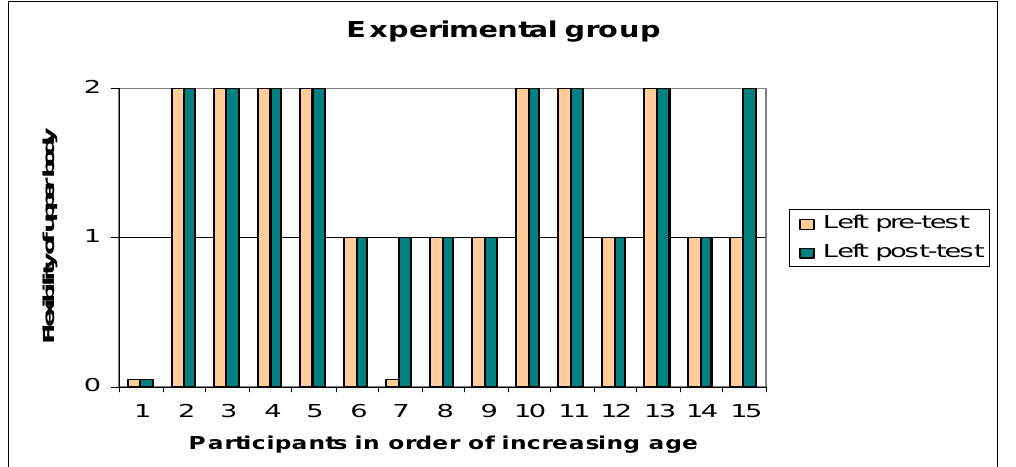
Figure 5. The classification of arm ROM: 0 = severe restriction of range of arm ROM, no hand contact with the wall; 1 = moderate restriction of arm ROM , only the fingers reach the wall: 2 = no restriction of arm ROM, the whole dorsal side of hand is in contact with the wall.